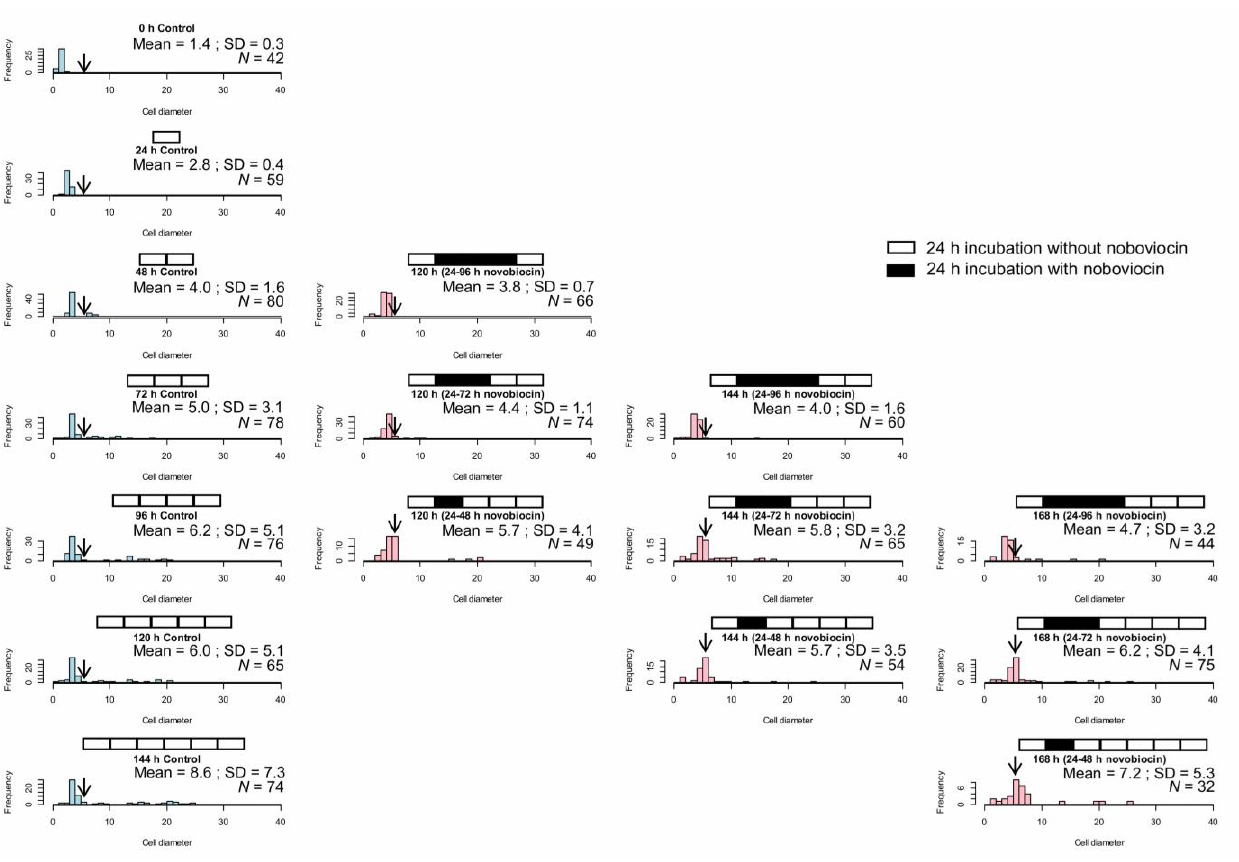
FIGURE 4: Size distribution of control E. faecalis protoplast cells and E. faecalis protoplast cells treated with novobiocin for different time periods (24, 48, and 72 h). The arrows indicate the fraction of cells with a diameter between 5 and 6